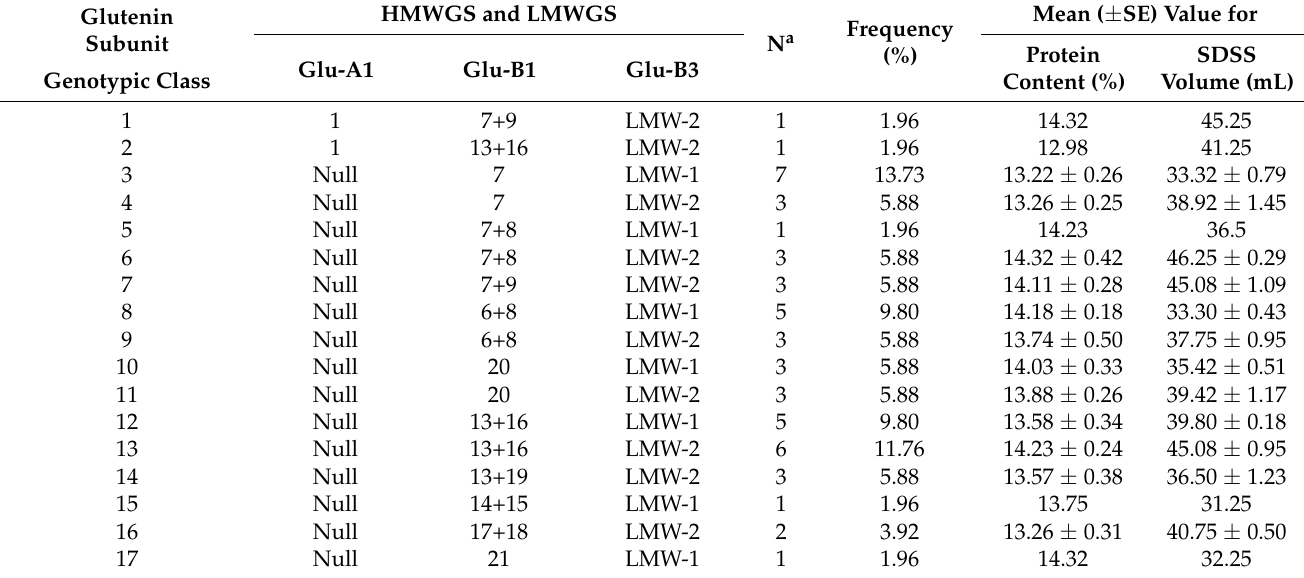
Table 1. Genotypic classes of different HMWGSs and LMWGSs as revealed by SDS-PAGE, and their mean values of protein content and SDSS